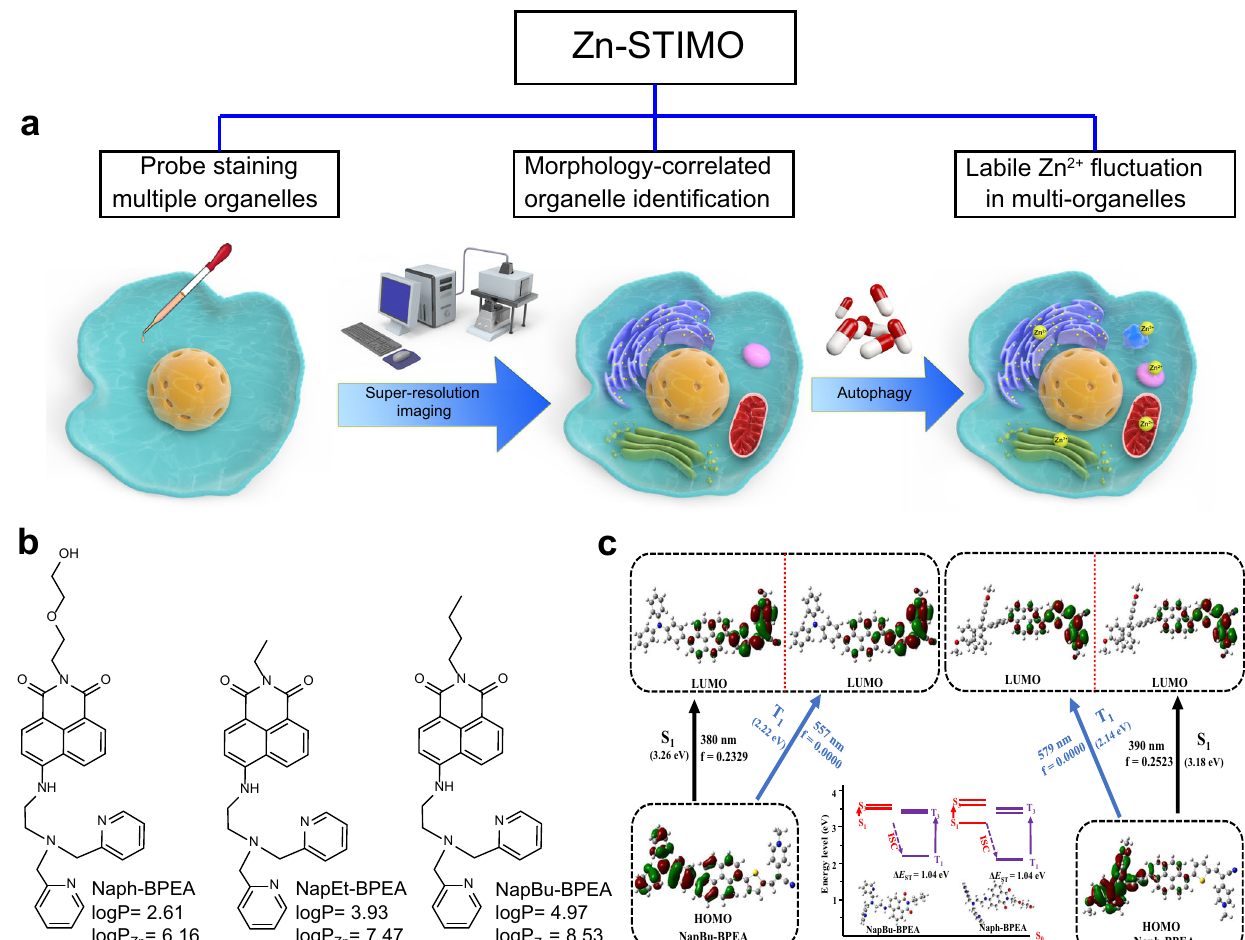
Fig. 1 Schematic illustration of Zn-STIMO and the design of probe candidate for Zn-STIMO. a General scheme of Zn-STIMO; b fl uorescent Zn 2 + probes Naph-BPEA, NapEt-BPEA, and NapBu-BPEA. LogP values are for free probes, while logP Zn values are for their zinc complexes formed with ZnCl 2 ; c calculated frontier molecule orbitals and energies of NapBu-BPEA and Naph-BPEA. Calculation was performed using TD-DFT//B3LYP/6-31G(d) level based on the geometry optimized by the DFT//B3LYP/6-31G(d) basis